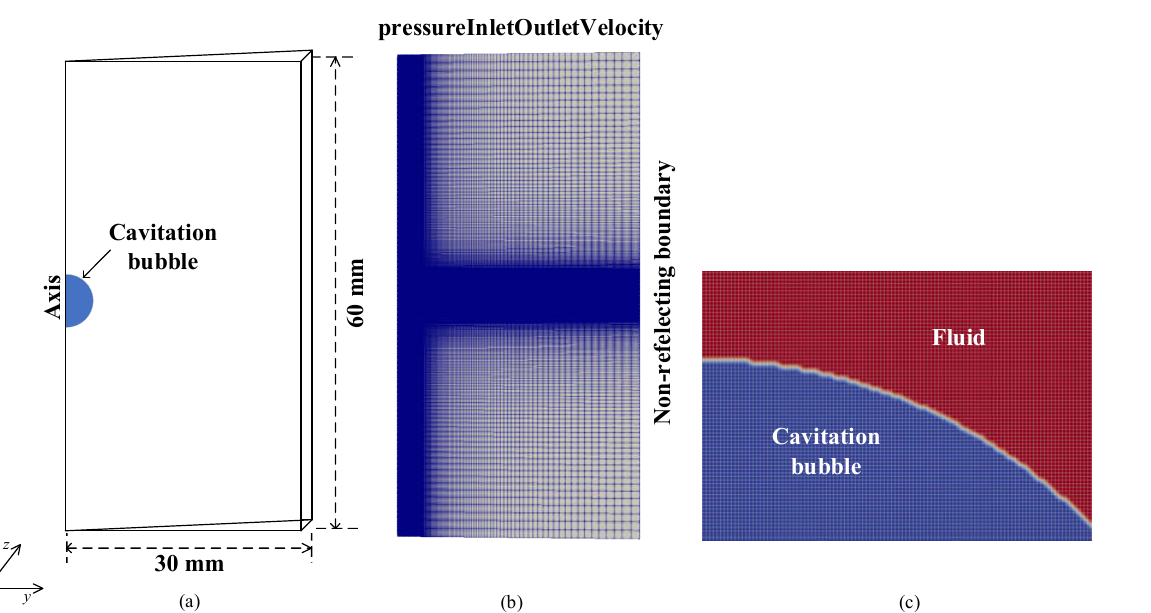
Figure 1. ( a ) Schematic diagram of the free flow-field calculation area; ( b ) boundary conditions and mesh information; ( c ) mesh details around the bubble.